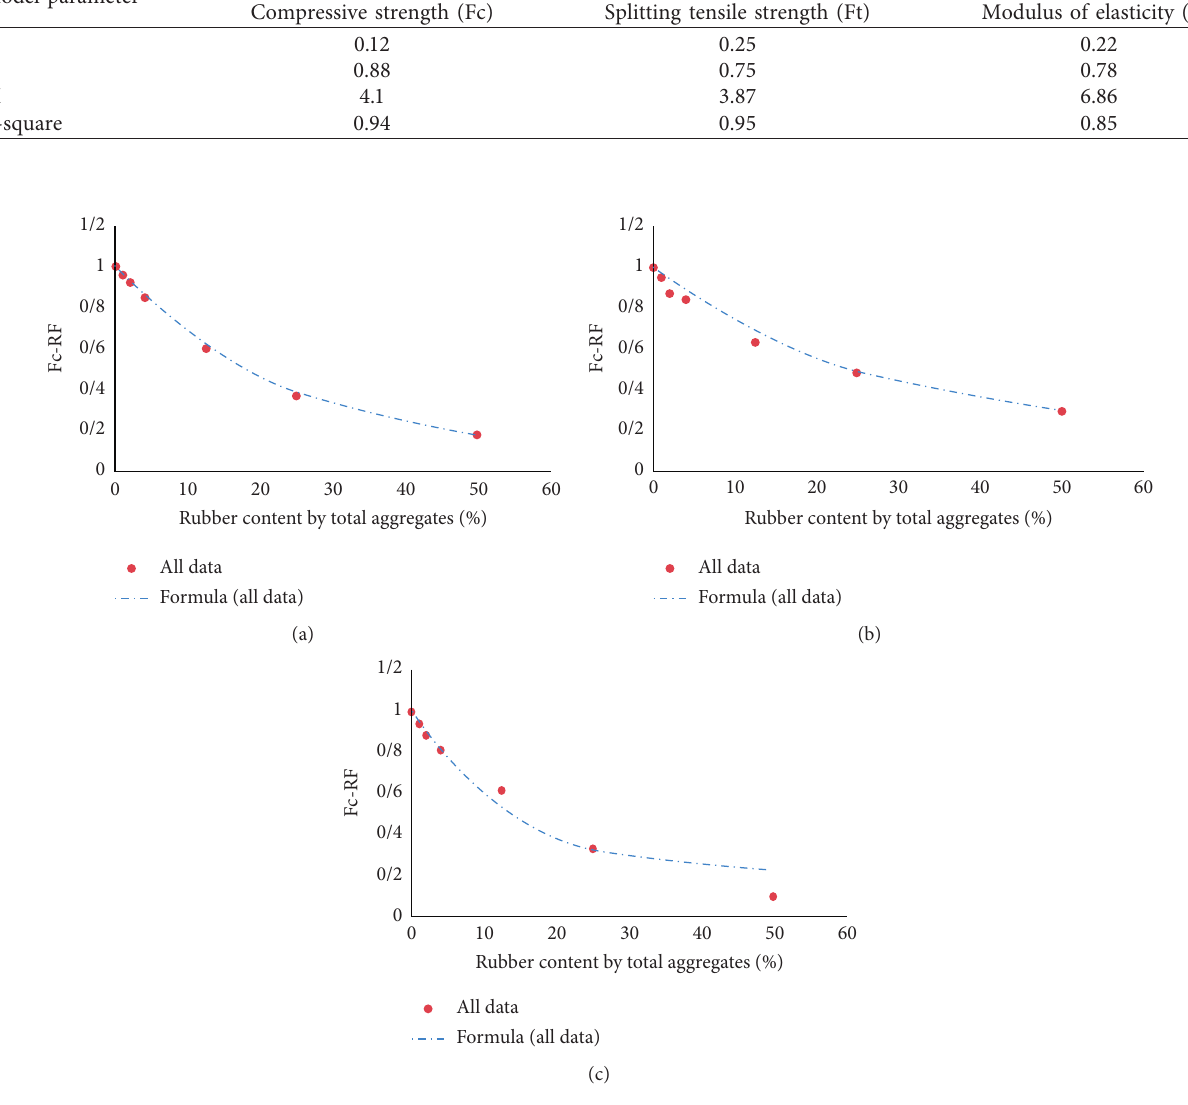
Figure 12: (a) Compressive strength reduction factor, (b) splitting tensile strength reduction factor, and (c) elastic modulus reduction factor of all types of rubberized concrete containing different silicone rubber content.